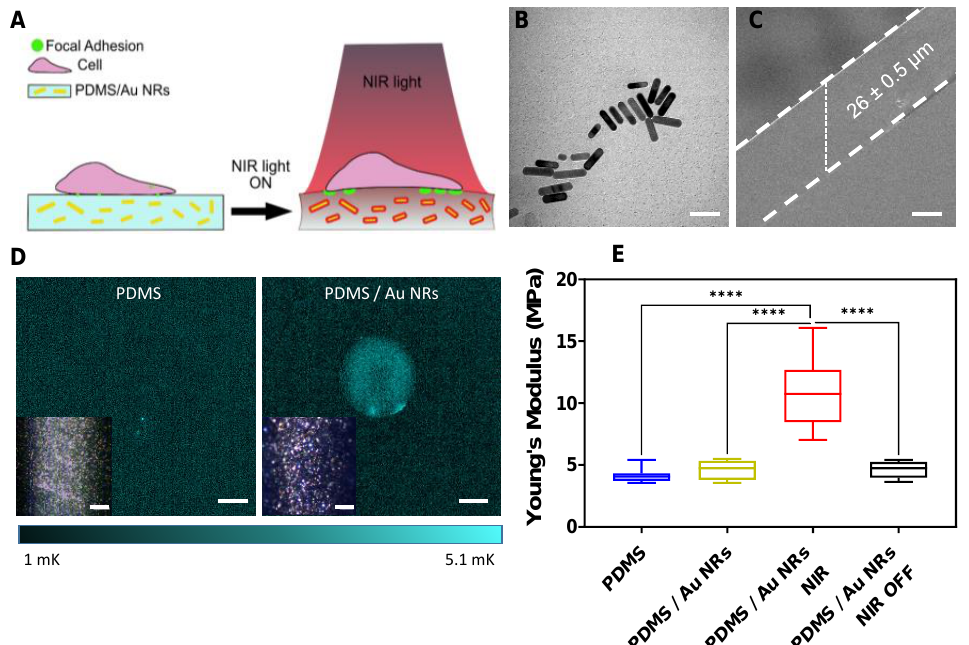
Figure 1. ( A ) Schematic representation of the light-responsive films used as cell culture substrates. Au NRs with LSPR centred at 803 nm were embedded in PDMS and used as photothermal transducers to manipulate cellular response in situ. By exposing the nanocomposite films to a NIR light source centred at 790 nm, a stiffening effect was achieved due to the constrained dilatation of the film, resulting in the clustering of FAs by fibroblasts. ( B ) TEM micrograph of the synthesised Au NRs. Scale bar: 50 nm. ( C ) SEM micrograph showing the lateral view of the films. Scale bar: 20 µ m. ( D ) LIT thermographs obtained upon irradiation with a light-emitting diode (LED) source centred at 525 nm for pure PDMS and PDMS/Au NRs films. Scale bar: 5 mm. Inset Cytoviva images of pure and PDMS/Au NRs films. Scale bar: 1 µ m. ( E ) Young’s Modulus obtained by nanoindentation on pure PDMS (blue), non-irradiated PDMS/Au NRs films (yellow), irradiated PDMS/Au NRs films (PDMS/Au NRs NIR, red), and post irradiated films (PDMS/Au NRs NIR OFF, black). Films were prepared at 2000 rpm for 1 min with 7.5 wt.% of Au NRs. One-way analysis of variance (ANOVA), post hoc Tukey’s test, **** p ≤ 0.0001.